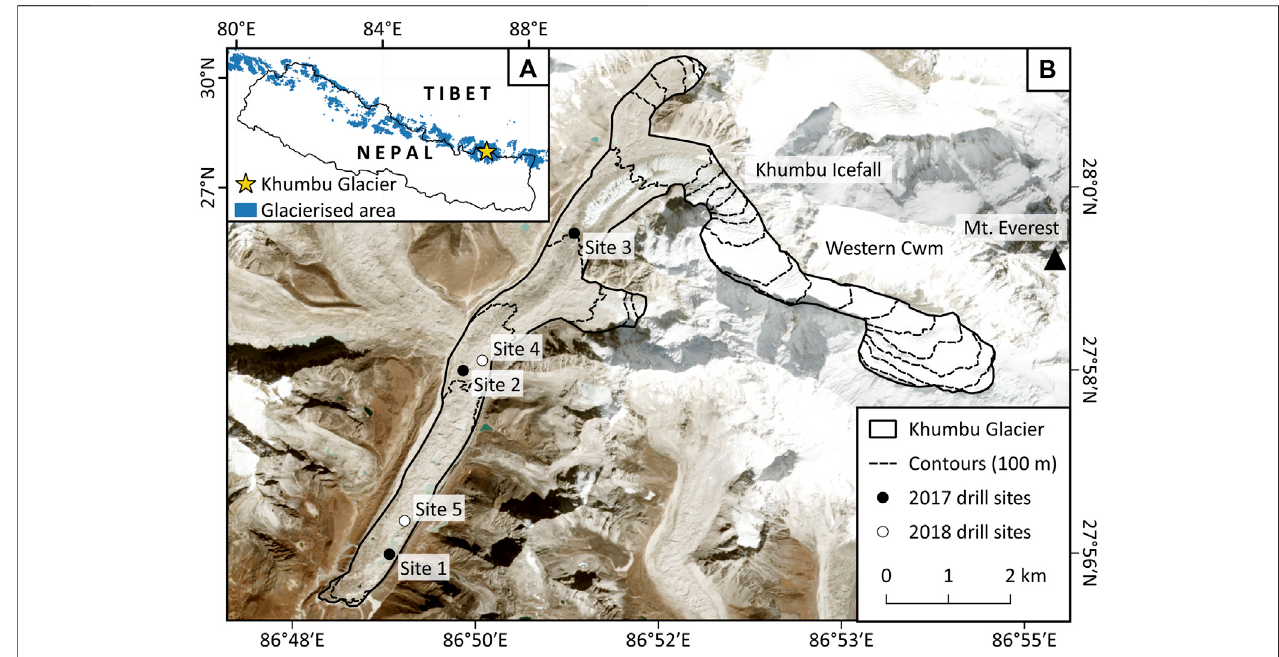
FIGURE 1 | Location of Khumbu Glacier and drill sites. (A) Location of Khumbu Glacier, Nepal. (B) Location of drill sites on the glacier in 2017 and 2018. Background is a Sentinel-2A image acquired on October 30, 2018 (Planet Team, 2017). Glacier contours are at 100 m intervals from 4,900 to 6,800 m a.s.l., created from the 2015 SETSM DEM (Noh and Howat,